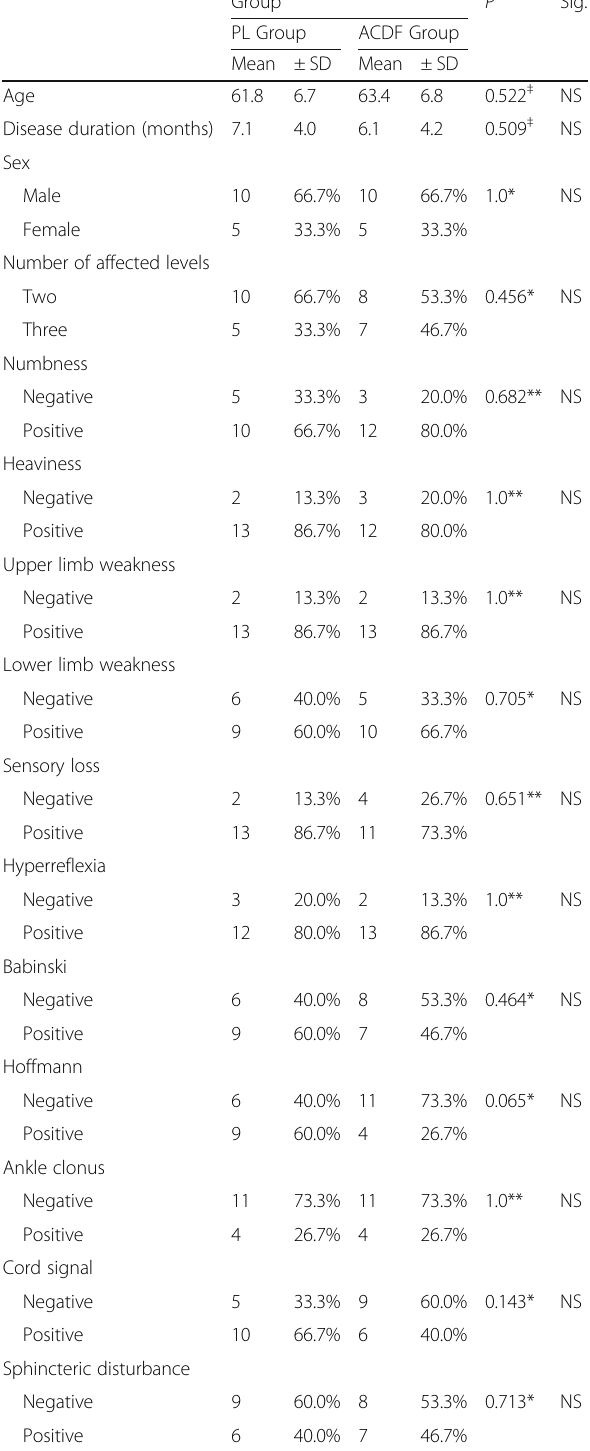
Table 1 Demographic and clinical data of the studied